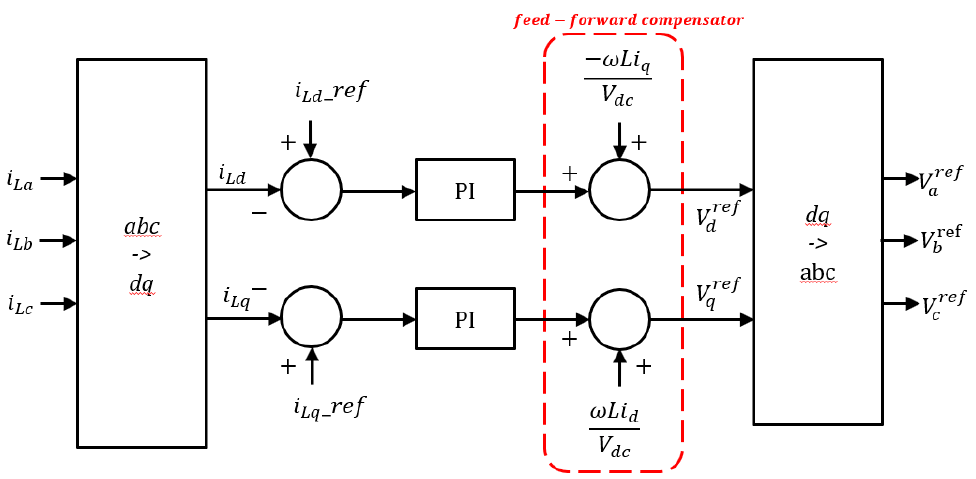
Figure 4. Microgrid inverter current controller.